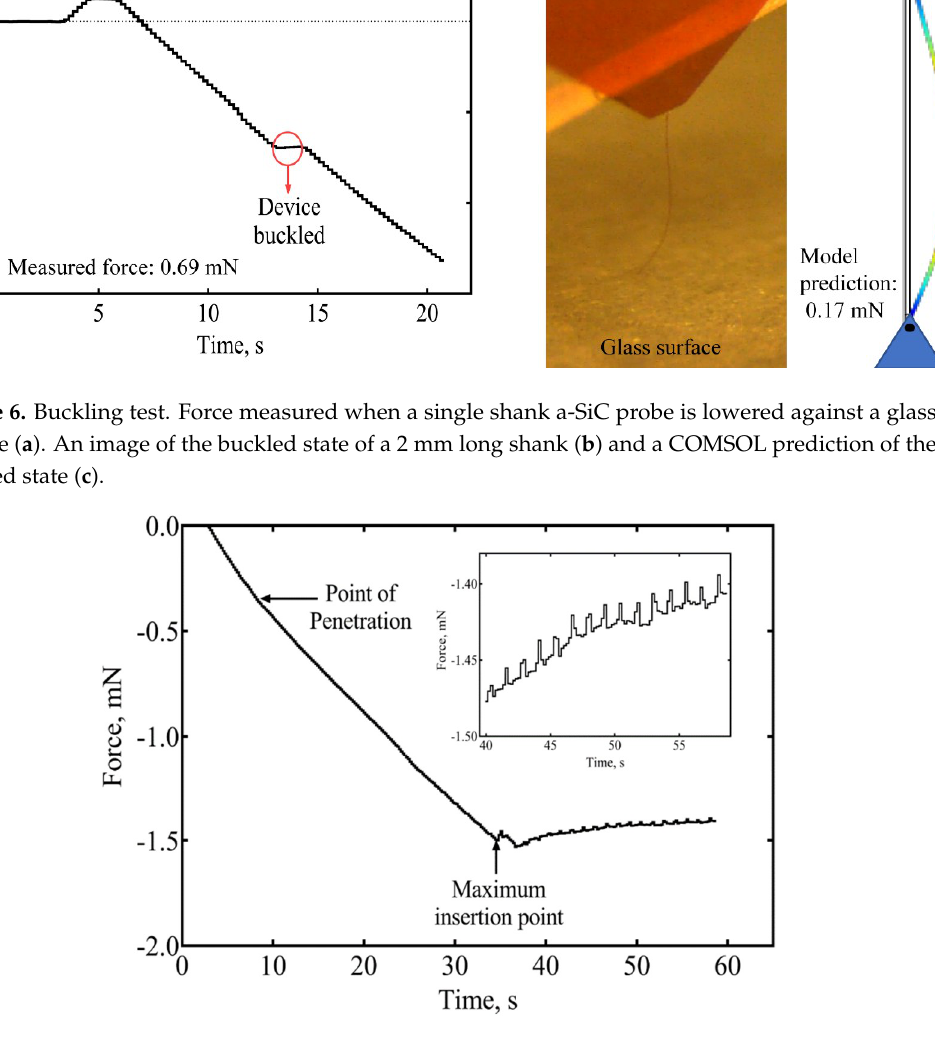
Figure 7. A representative example of the insertion force recorded during the insertion of a 6 μm × 7 μm a-SiC shank into rat cortex. An insertion force of 0.35 mN was recorded at the point of insertion. Inset shows forces experienced by the indwelling shank at 2 mm insertion